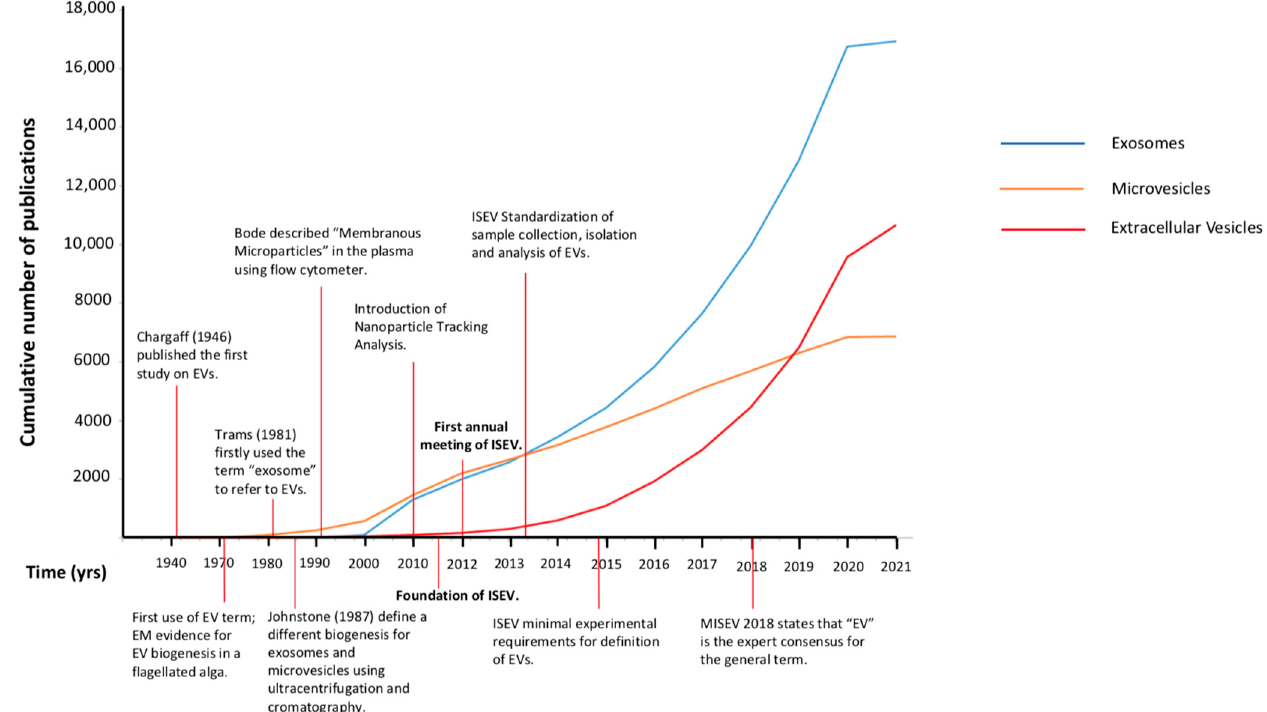
Figure 2. Cumulative number of publications. Comparative evolution of the use of different terms for EVs (exosomes, microvesicles or extracellular vesicles) in the literature from 1946 to 2021. EVs: extracellular vesicles; EM: electron microscopy; ISEV: International Society of Extracellular Vesicles; MISEV: minimal information for studies of extracellular vesicles.